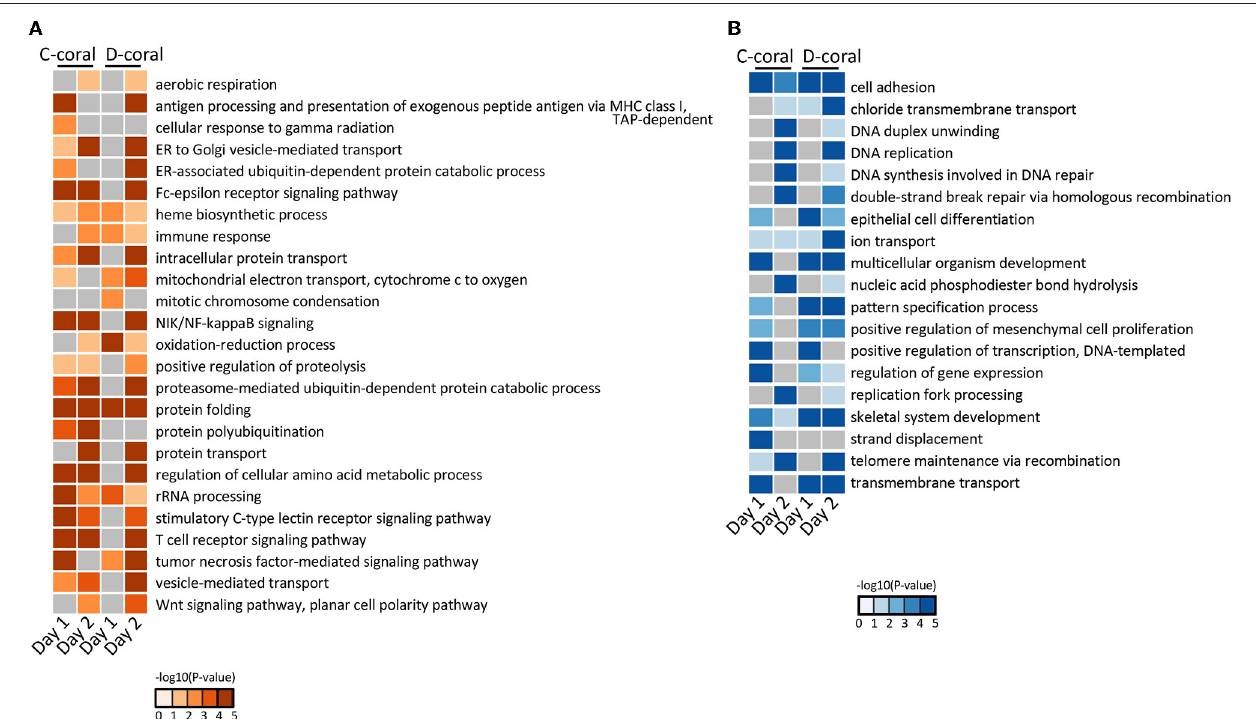
FIGURE 2 | Heatmap of enrichment scores [–log10 ( p -value)] from GO enrichment analysis using upregulated coral DEGs (A) and using downregulated coral DEGs (B) . The detected significantly ( p < 0.05) enriched GO terms in biological process are shown.